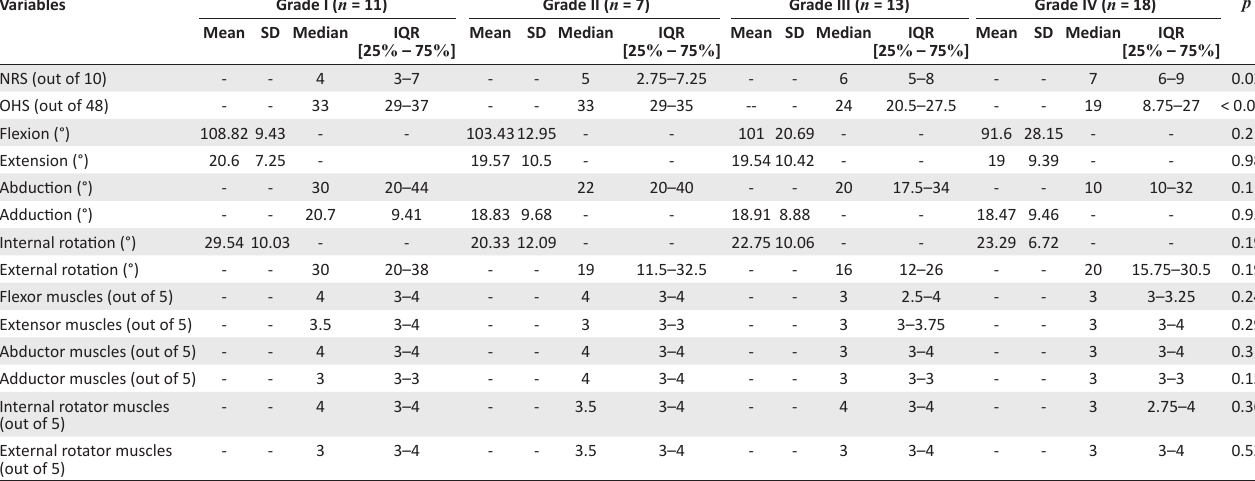
TABLE 5: Comparison of body structures and function based on grades of hip osteoarthritis. Variables